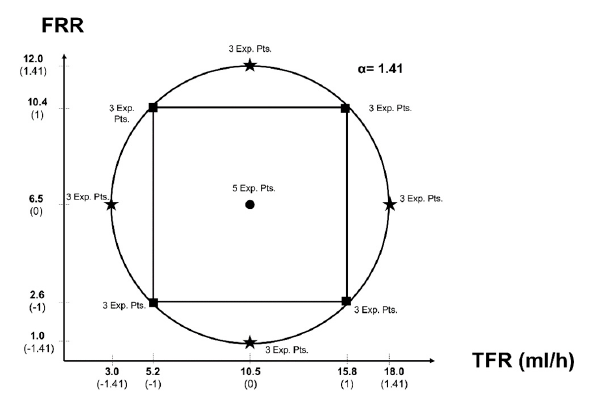
Figure 2. Central Composite Circumscribed Rotatable (CCCR) Design. All experimental points are at the same distance from the center. The experimental design has four axial points and four cubic points, each one with three repetitions and one central point with five repetitions. α = 1.41. Coded values are in